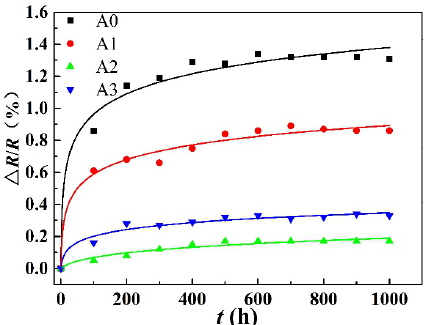
Fig. 13 Relative resistance drift of MCNS ceramics at 125 ℃ of 1000 h.